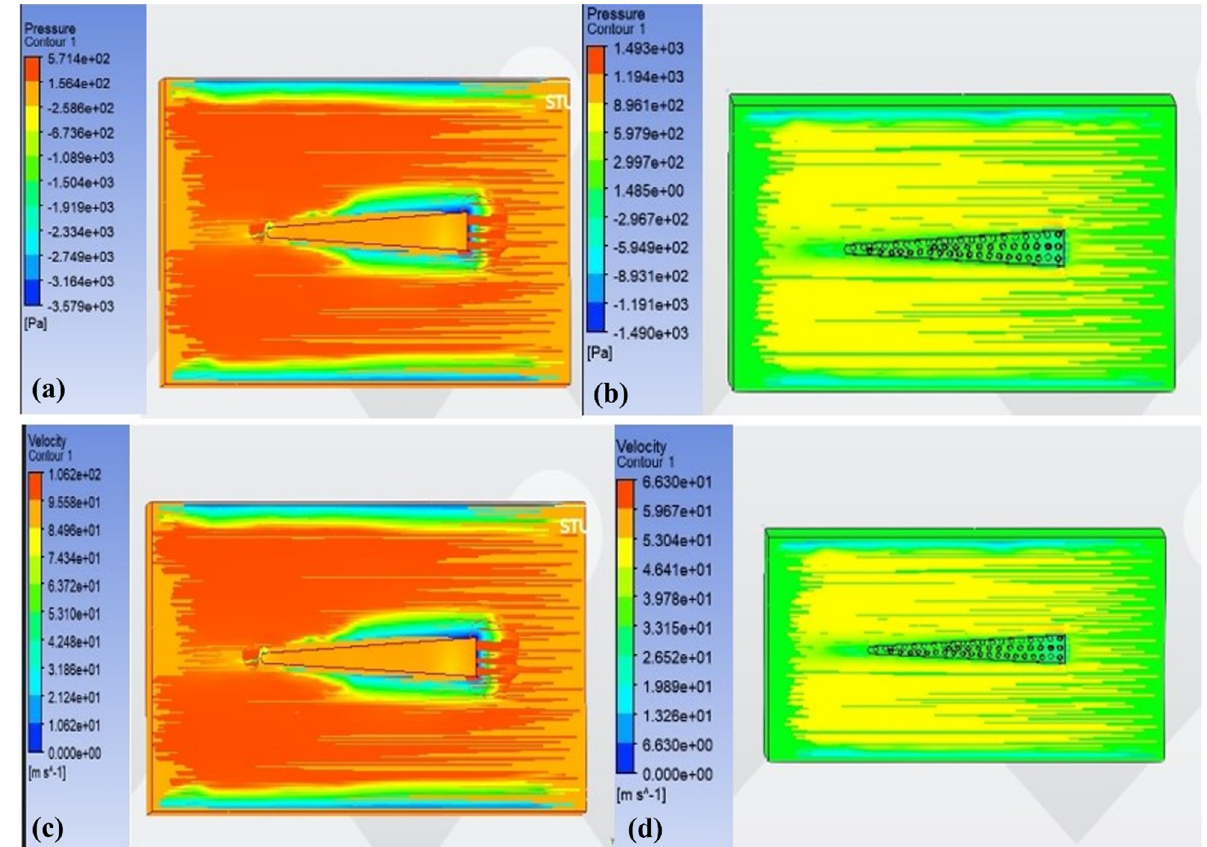
Figure 10a,b show the velocity contours for the normal and dimpled sections, respec- tively. Similarly, Figure 10c,d illustrate the pressure contours for the normal and dimpled sections. For showing the fully developed flow, the lift and drag convergences are shown in Figure 11.